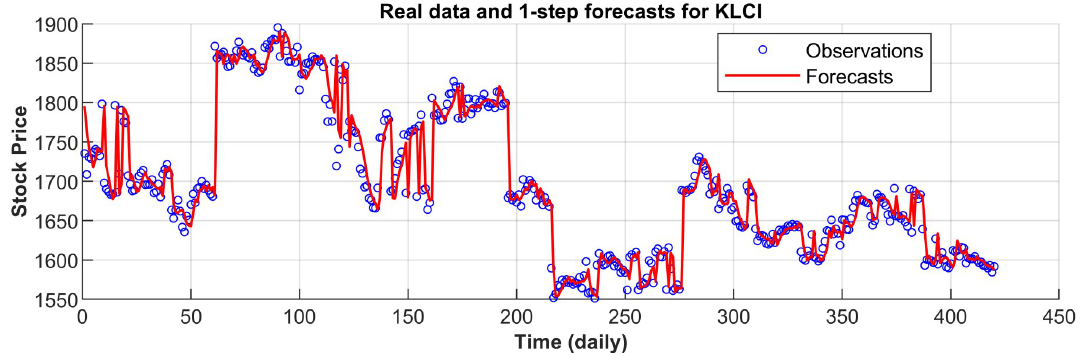
Fig 12. 1-step forecasts of the nPRM and market values for Malaysia